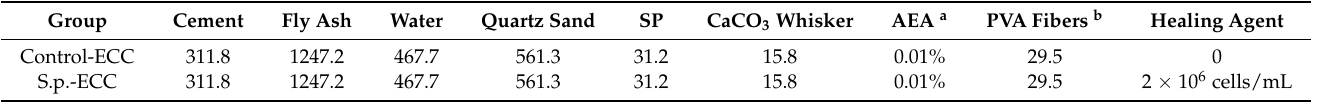
Table 1. Mix proportion of ECC (kg/m 3 ).